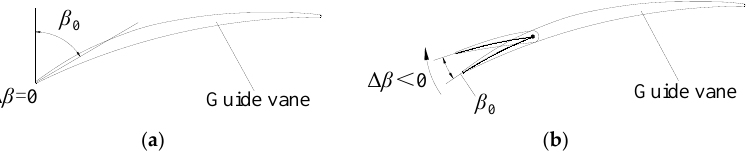
Figure 3. The turn direction of guide vane inlet angle. ( a ) Inlet angle of guide vane ( ∆ β = 0), ( b ) clockwise rotation ( ∆ β < 0).